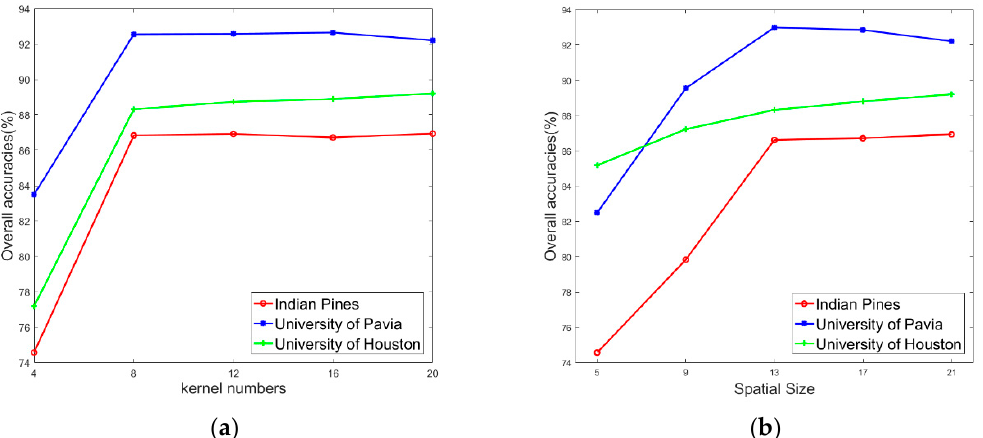
Figure 5. Effect of network hyper-parameters. ( a ) overall accuracy (OA) of different kernel numbers. ( b ) OA of different spatial size.